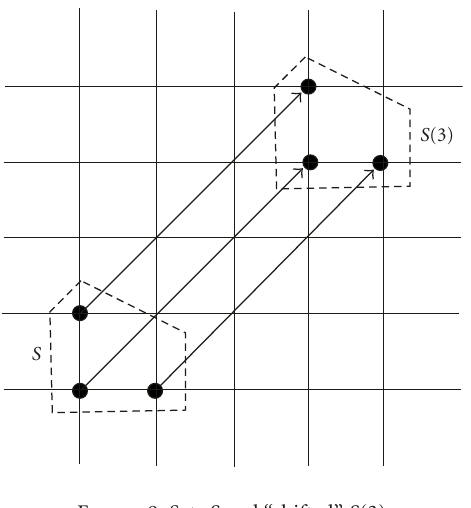
Figure 8: All packets will arrive in the diagonal nodes within the center (cid:4) H × (cid:4) H square, S i .